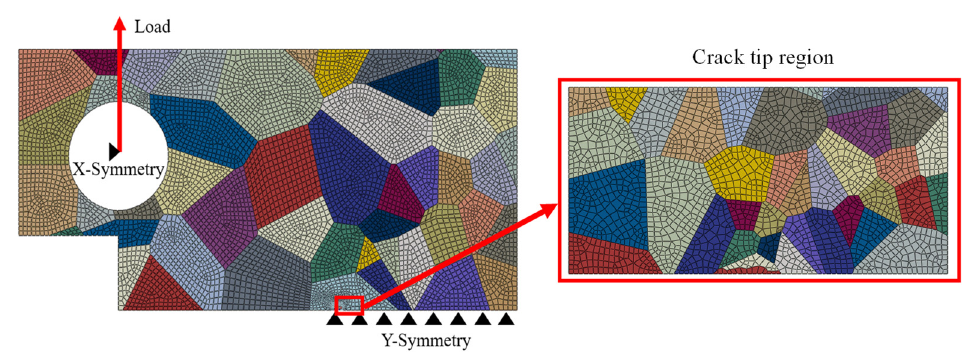
Figure 11. Voronoi model and boundary conditions of CT model.